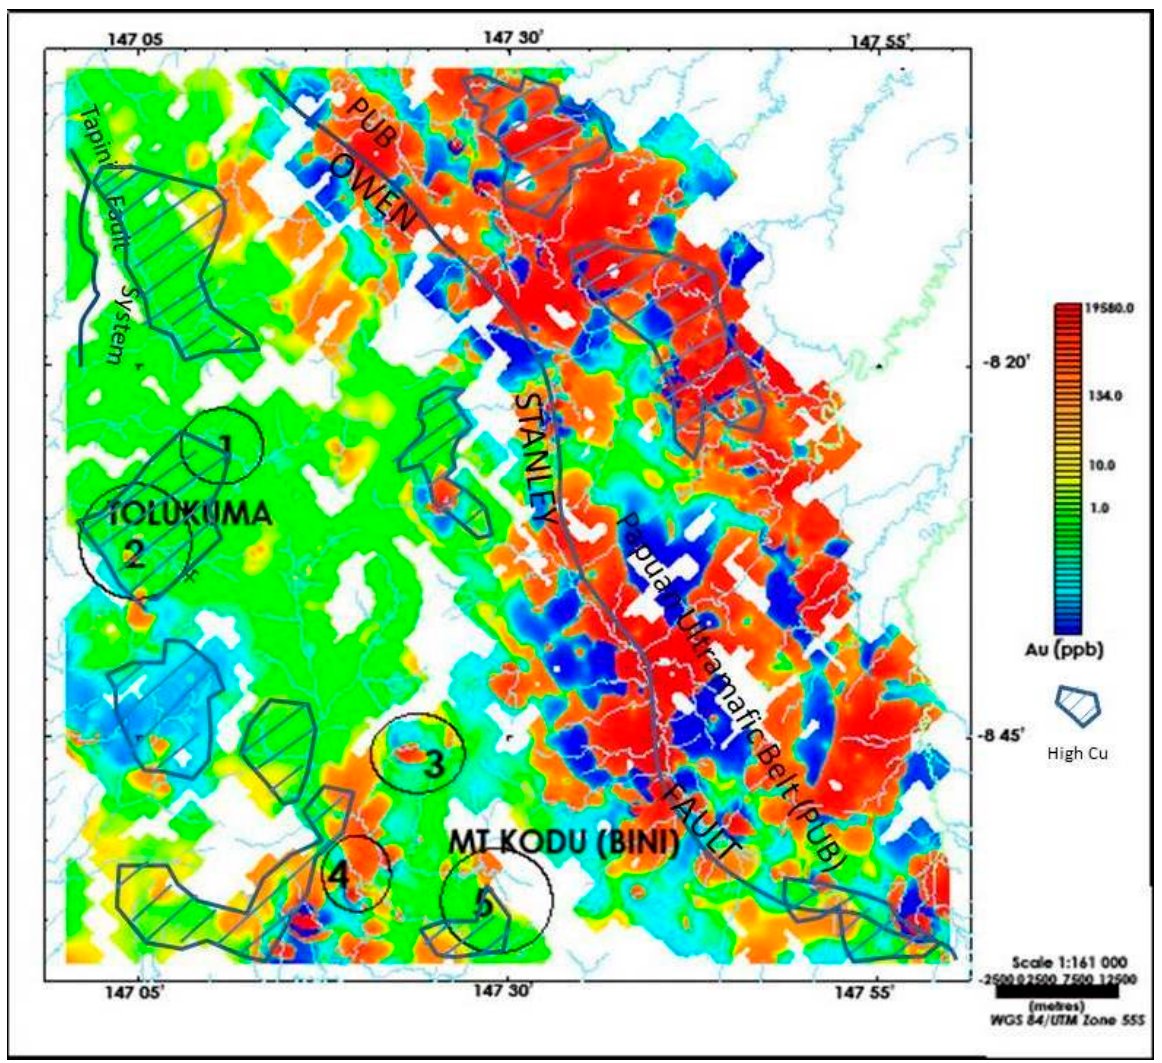
Figure 6. Distribution of gold in the stream sediments within the study area. Hatched polygons indicate areas of high Cu occurrences. Numbers 1 − 5 indicate magnetic anomalies shown in Figure 3.